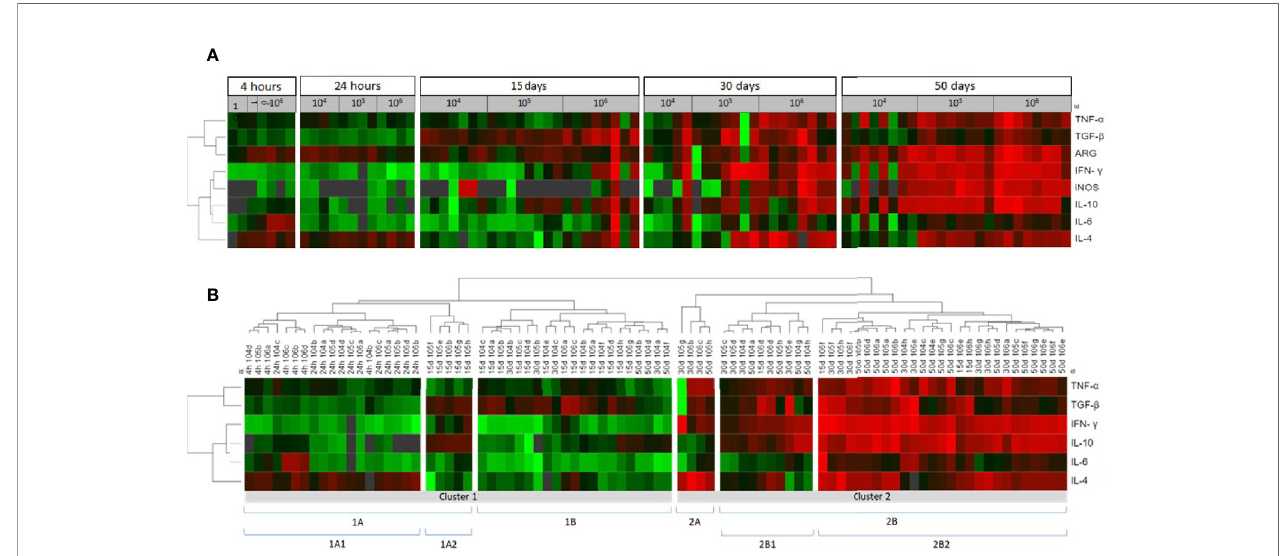
FIGURE 4 | Cytokine, iNOS and arginase in the skin lesions of hamsters infected with Leishmania (Viannia) braziliensis according to a comparative gene expression heatmap analysis. (A) The animals were grouped by post infection time (4 and 24 hours; and 15, 30 and 50 days) and different inocula (10 4 , 10 5 , and 10 6 promastigotes). Heatmap analyses were performed for gene expression ( tnf, tgf b , ifn g , il10, il6, il4, arg, inos ) DD Ct using the online Heat mapper ® software. (B) The animals were clustered by gene expression signature. The hierarchy average linkage clustering method with Euclidean distance measurement was used (Wishart Research Group at the University of Alberta). Each row represents one molecule and each column represents one animal. Higher gene expression is displayed in red, and lower gene expression, in green. Gray indicates mean gene expression below the lower limit of